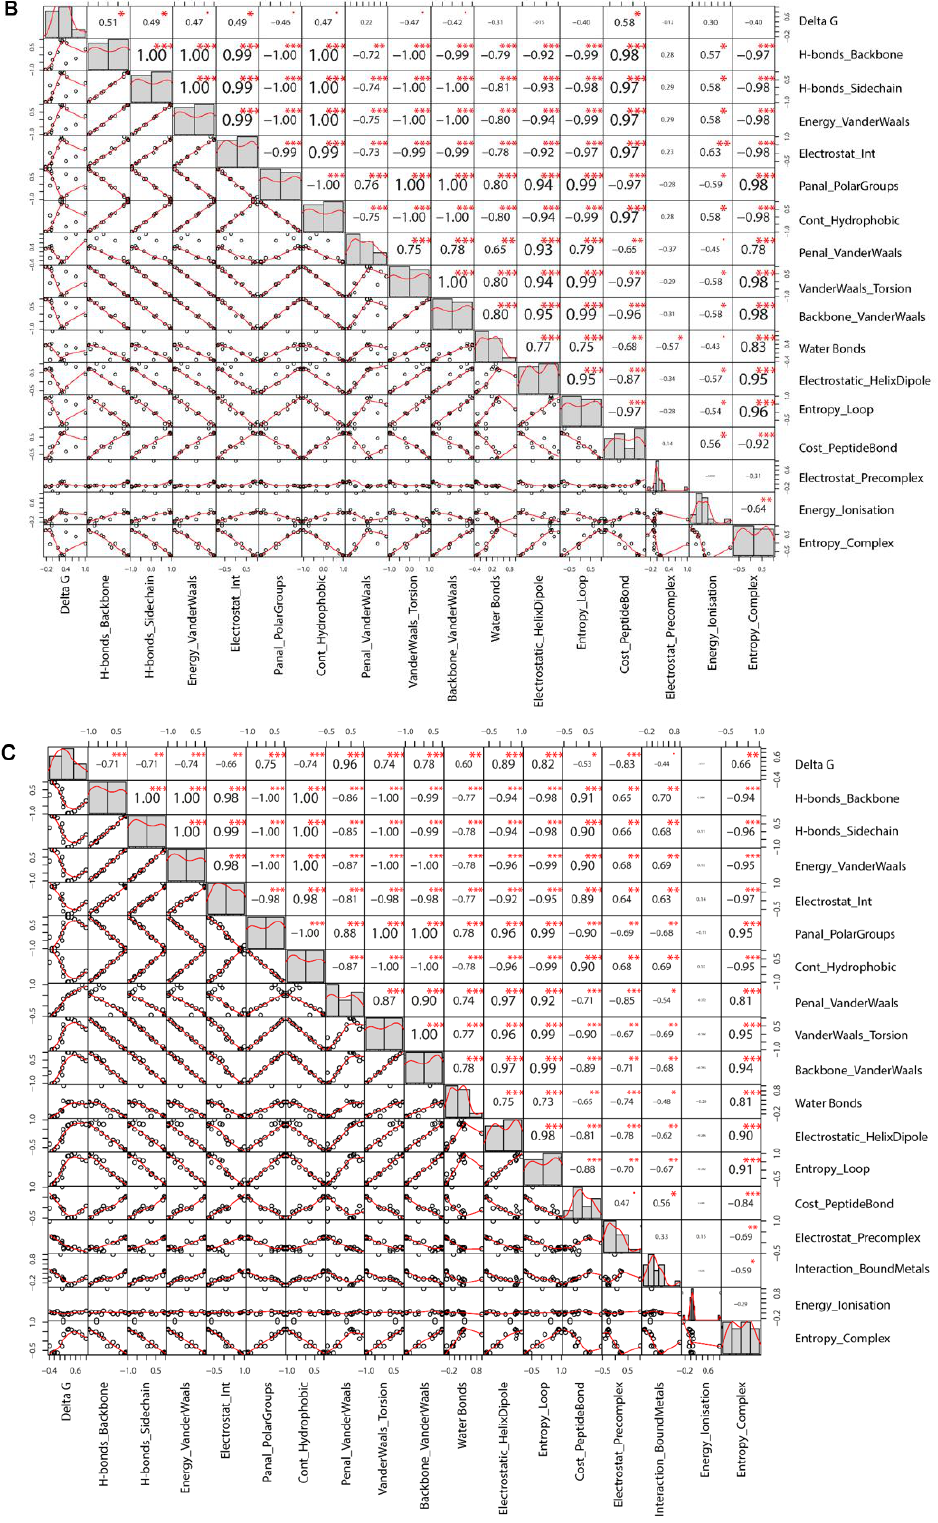
Figure 3. Electrochemical properties. ( A ) Box plots rendering the interquartile range (IQR) and the horizontal bar the median relative expression. Expression values that do not fall within 1.5 x IQR are outliers and are indicated by circles where appropriate. ( B ) Correlation matrix for parameters of non-oscillating genes. Numbers in the boxes are Spearman’s correlation coe ffi cients. ( C ) Correlation matrix for parameters of oscillating genes. Numbers in the boxes are Spearman’s correlation coe ffi cients. Asterisks represent statistically significant correlations (* p < 0.05, ** p < 0.01, *** p <